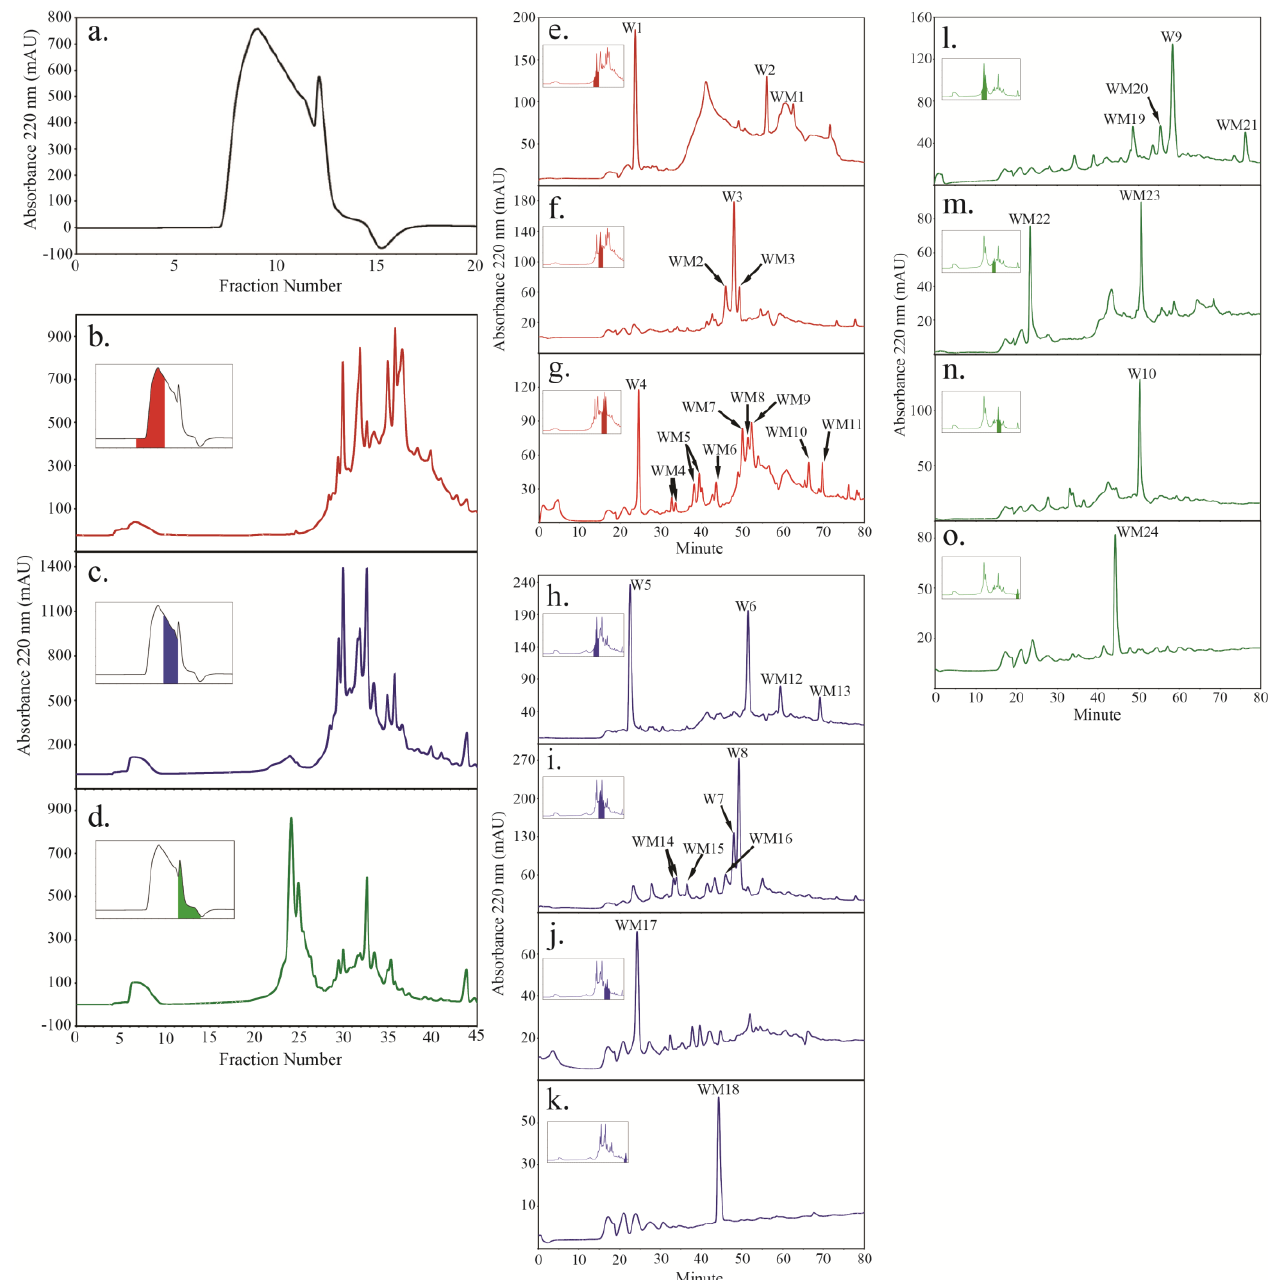
Figure 2. Peptides were isolated from trypsin digested WT HFI using a combination of size exclusion chromatography (SEC) ( a ), strong cation exchange chromatography (SCX) ( b – d ) and reverse phase chromatography ( e – o ), also summarized in Figure 1. Color-coded inserts in panels b to d identify the SEC fractions taken in turn for peptide mapping by SCX. Color- coded inserts in panels e through o identify the SCX fractions taken in turn for further peptide mapping by reverse phase chromatography. Major peptide peaks (A220 > 100) from WT HFI are labeled with “W” while minor peptides are labeled as